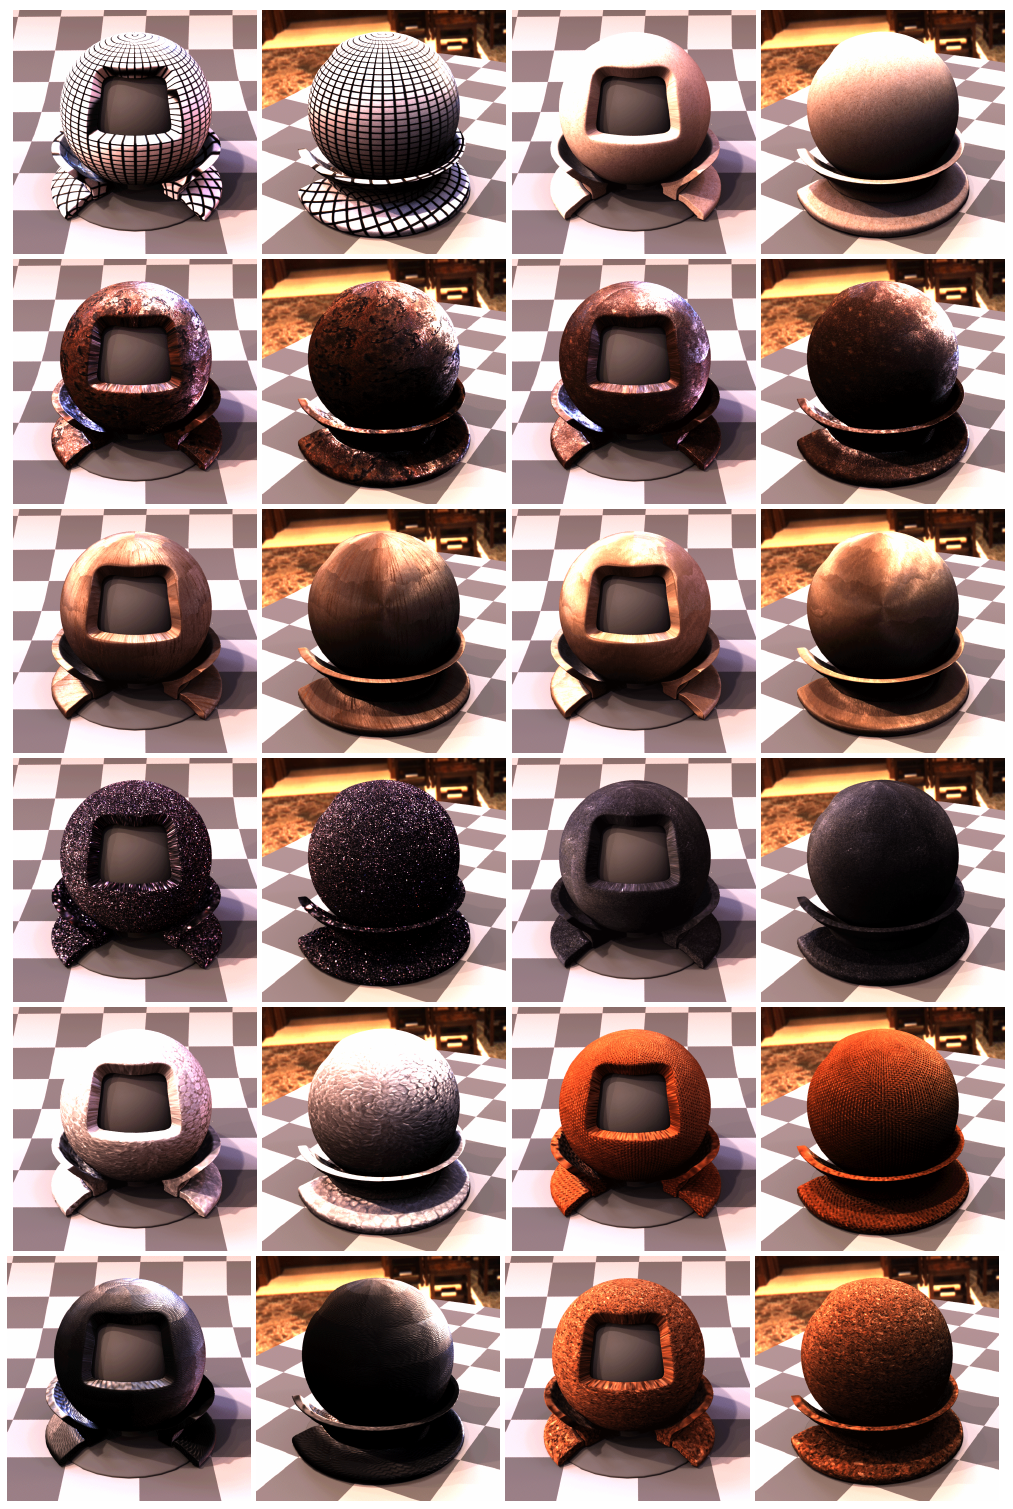
Figure 27. Twelve material samples from other categories, measured by lightdrum, put onto the 3D object and rendered by Mitsuba rendering software under two different views. Materials (top-left to bottom-right): office paper with printed grid 5 5 mm 2 as used in demonstrations in Section 11, × paper002, stone001, stone002, balsa wood, poplar wood, softening material 001, softening material 002, polystyrene coarse, hardboard, car upholstery, coarse